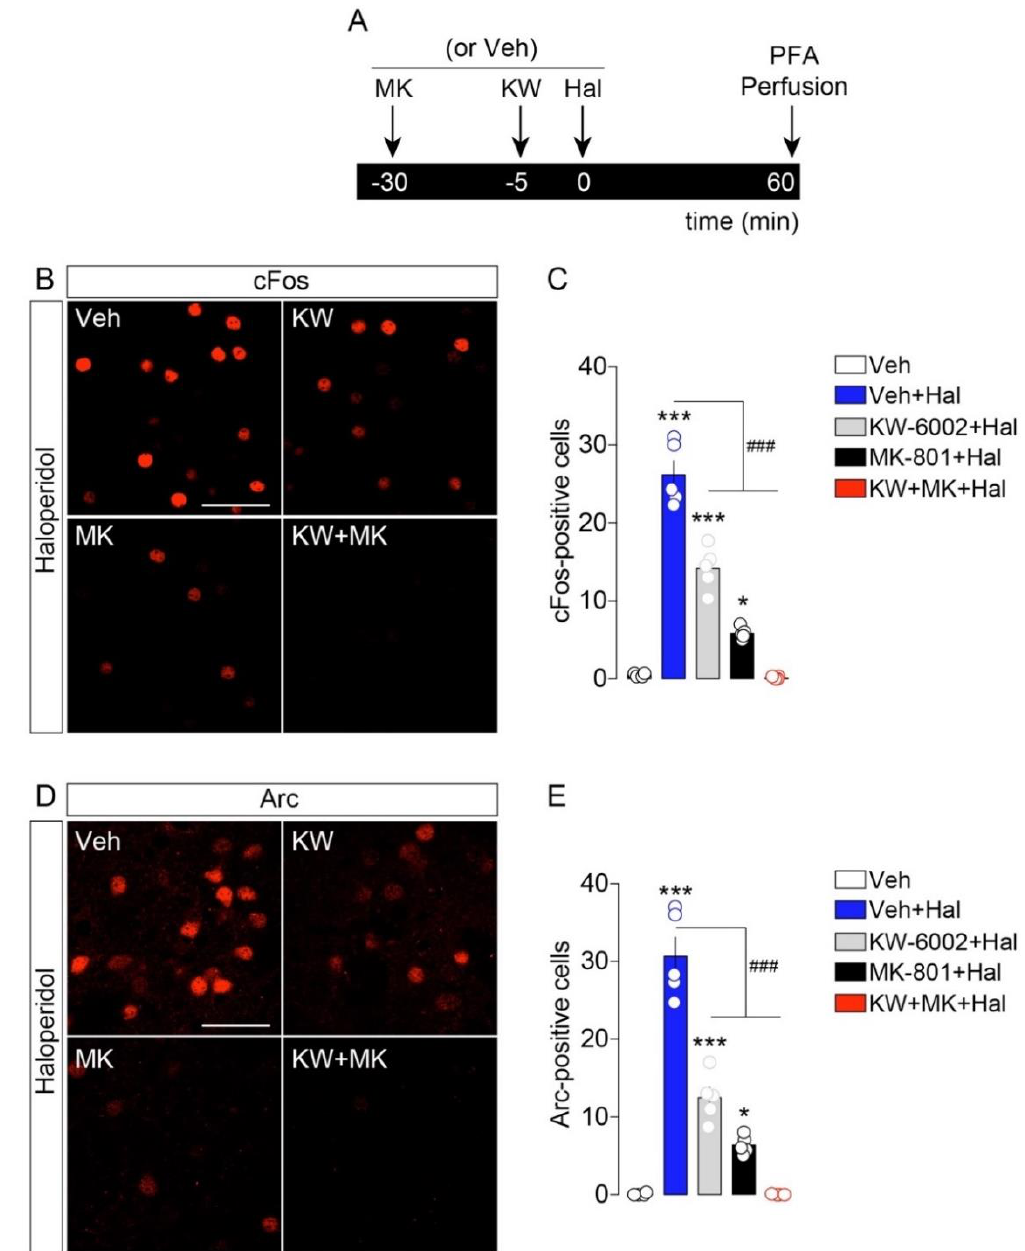
Figure 3. Haloperidol-induced cFos and Arc require the activation of A2a and NMDA receptors. ( A ) Temporal schedule of pharmacological treatments. ( B ) Immunofluorescence detection of cFos in the striatum of animals treated with vehicle + haloperidol ( n = 5), KW-6002 (KW) + haloperidol ( n = 5), MK-801 (MK) + haloperidol ( n = 5) and KW-6002 (KW) + MK-801(MK) + haloperidol ( n = 5). Note: given the low number of IEGs-positive neurons in Veh-treated mice, pictures are not shown. Scale bar: 50 µ m. ( C ) Quantification of cFos + -neurons in all experimental groups. Statistics: * p < 0.05 and *** p < 0.001 (drugs vs. vehicle), ### p < 0.001 (KW-6002 + haloperidol and MK-801 + haloperidol vs. haloperidol). One-way ANOVA: F (4, 19) = 113.9, p < 0.0001. ( D ) Immunofluorescence detection of Arc in the striatum following pharmacological administrations. Scale bar: 50 µ m. ( E ) Quantification of Arc + -neurons. Statistics: * p < 0.05 and *** p < 0.001 (drugs vs. vehicle), ### p < 0.001 (KW-6002 + haloperidol and MK-801 + haloperidol vs. haloperidol). One-way ANOVA: F (4, 19) = 90.46, p <